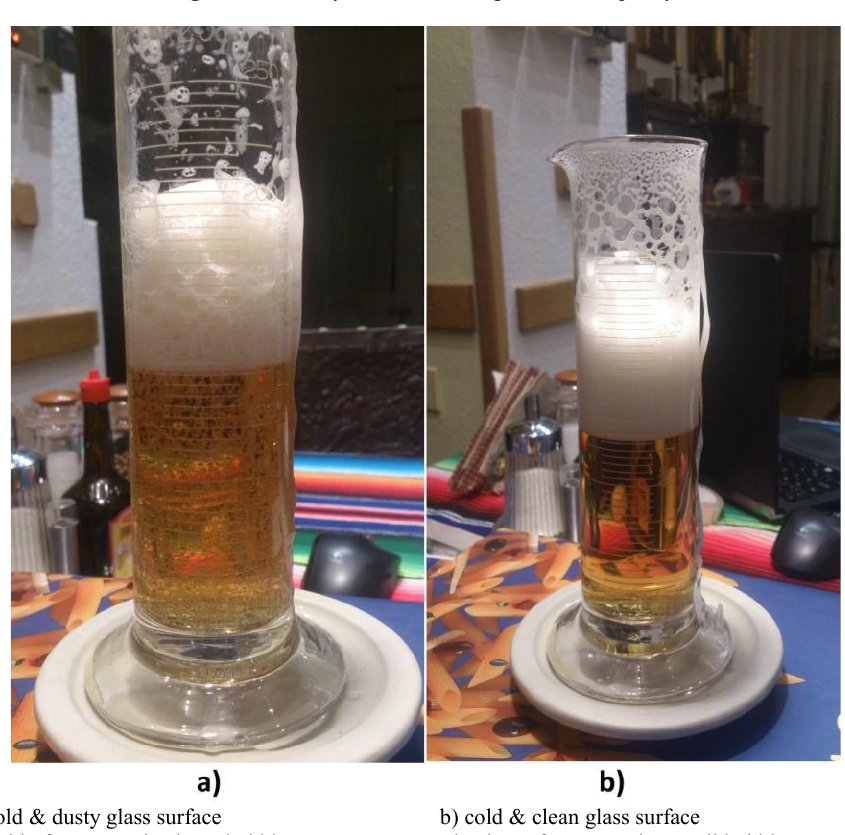
Fig. 5. Foam quality – effect of glass surface